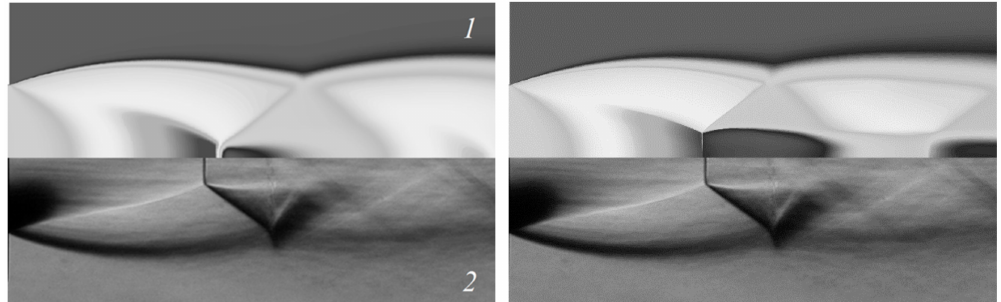
Figure 14. Comparison of the calculated and experimental flow patterns (preliminary calculation)